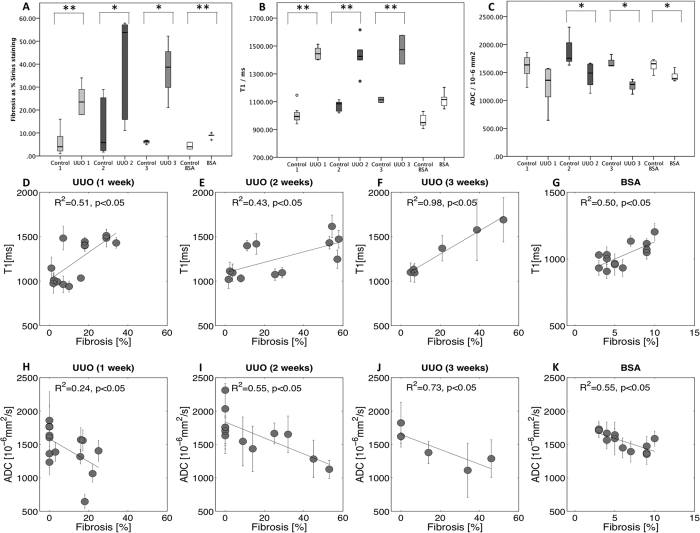
Histological and MRI results box plot for the UUO and BSA model.The 3 boxes plot illustrate the differences between the control and the model
for histological results (A), the mean T1 [ms] (B) and mean
ADC [10−6 mm2/s] (C)
for UUO and BSA: UUO at time point 1 week (UUO1), 2 weeks (UUO2), 3 weeks
(UUO3) and BSA at time point 3 weeks. In UUO, the contralateral kidney
served as control. Data were obtained in 29 rats (7 for UUO1, 6 for UUO2, 3
for UUO3, 5 in the BSA group and 8 controls), with
p < 0.001 (**) and with
p < 0.05 (*). (B) A highly significant
difference in T1 was revealed between the control and obstructed kidneys in
the UUO model at the three time points but only a trend was observed for the
BSA model (p = 0.06). In all case, T1 strongly
correlated with the percentage of cortical IF as assessed by Sirius red
staining (R2 = 0.51 at 1 week
(D), R2 = 0.43 at 2 weeks
(E), R2 = 0.98 at 3 weeks
(F), p < 0.05) and
R2 = 0.50,
p < 0.05 for the BSA 3 weeks (G). ADC
was significantly different between the control and both the UUO model at 2
and 3 weeks (p = 0.013 and
p = 0.014) and the BSA model
(p = 0.007). The difference in ADC was not
significant in the mild UUO model at time point 1 week
(p = 0.052) (C). In all cases, ADC inversely
correlated with the percentage of cortical IF as assessed by Sirius red
staining (R2 = 0.24 at 1 week
(H), R2 = 0.55 at 2 weeks
(I), R2 = 0.73 at 3 weeks
(J), p < 0.05) and
R2 = 0.55,
p < 0.05 for the BSA 3 weeks (K).